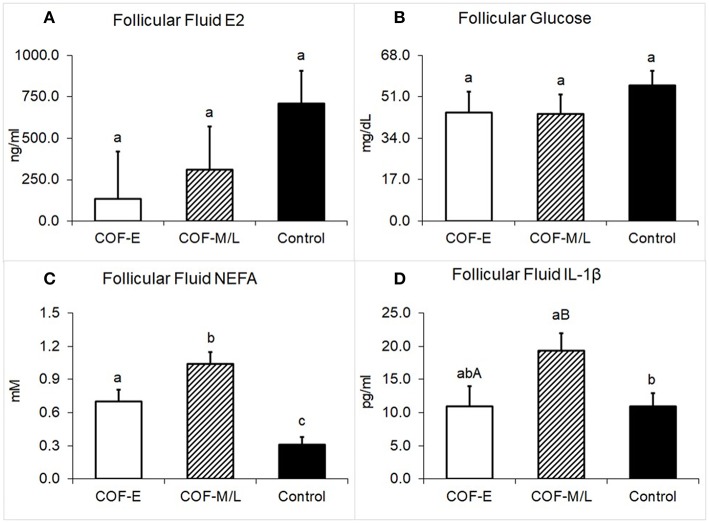
Follicular fluid concentration for (A) E2, (B) Glucose, (C) NEFA, and (D) IL-1β in cows diagnosed with COF at early (COF-E) and mid-late (COF-M/L) lactation and the control cows. Different letters (a,b) represent different (P < 0.05) least-square means and capital letter (A,B) represent tendencies (0.05 < P ≤ 0.10). Error bars represent the mean standard error.